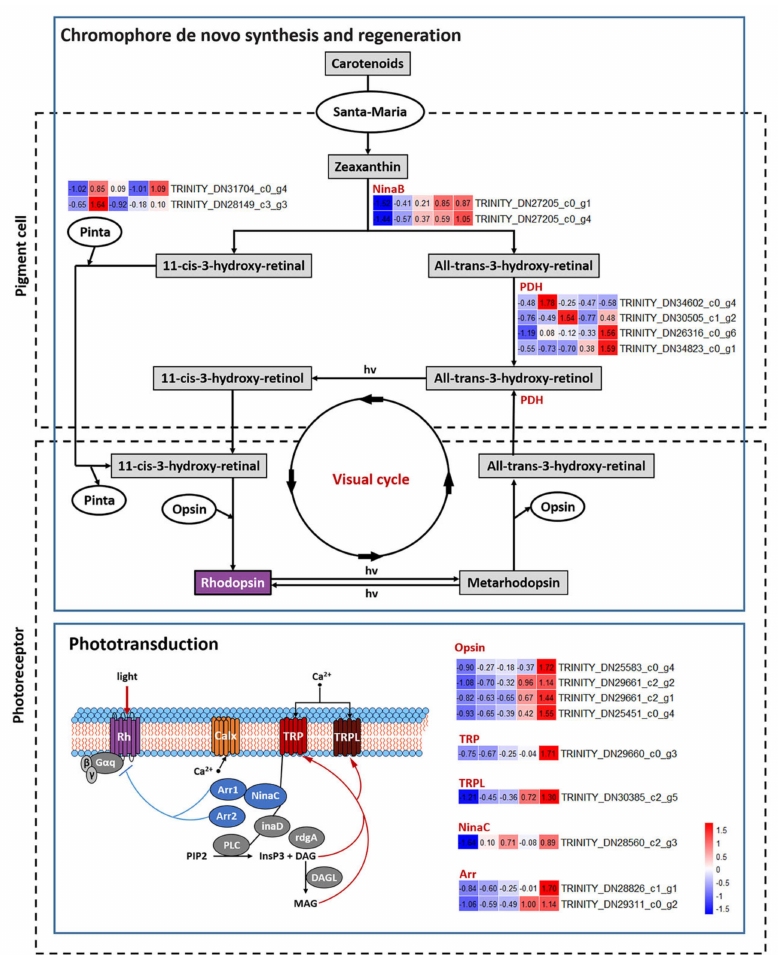
Figure 5. Expression patterns of key DEGs related to structure of visual system. Chromophore de novo synthesis and regeneration is related to the genes encoding retinoid-binding protein (Pinta, two genes (non DEGs)), β , β -carotene-15,15 (cid:48) monooxygenase (NinaB, two genes), photoreceptor dehy- drogenase (PDH, four genes). Phototransduction is related to the genes encoding Ca 2+ -permeable light-sensitive transient receptor potential channel (TRP), Ca 2+ -permeable light-sensitive transient receptor potential-like channel (TRPL), myosin III (NinaC), arrestin homologs (two genes), opsins (four genes). The heatmaps based on TPM show the expression levels of the corresponding protein or enzyme genes in five development stages (from left to right, the 5th-instar with white compound eyes (N5W), with red compound eyes (N5R), with dark brown compound eye (N5B), and the adults after emergence at 3 h (A3), 48 h